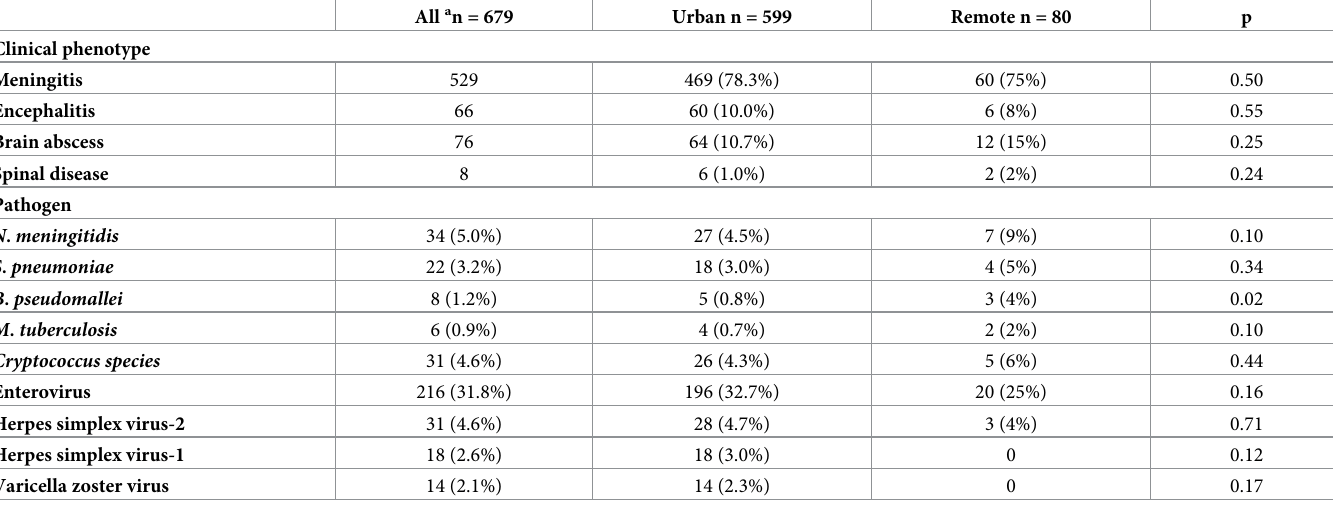
Table 4. The number of cases in urban and remote areas within FNQ by clinical phenotype and